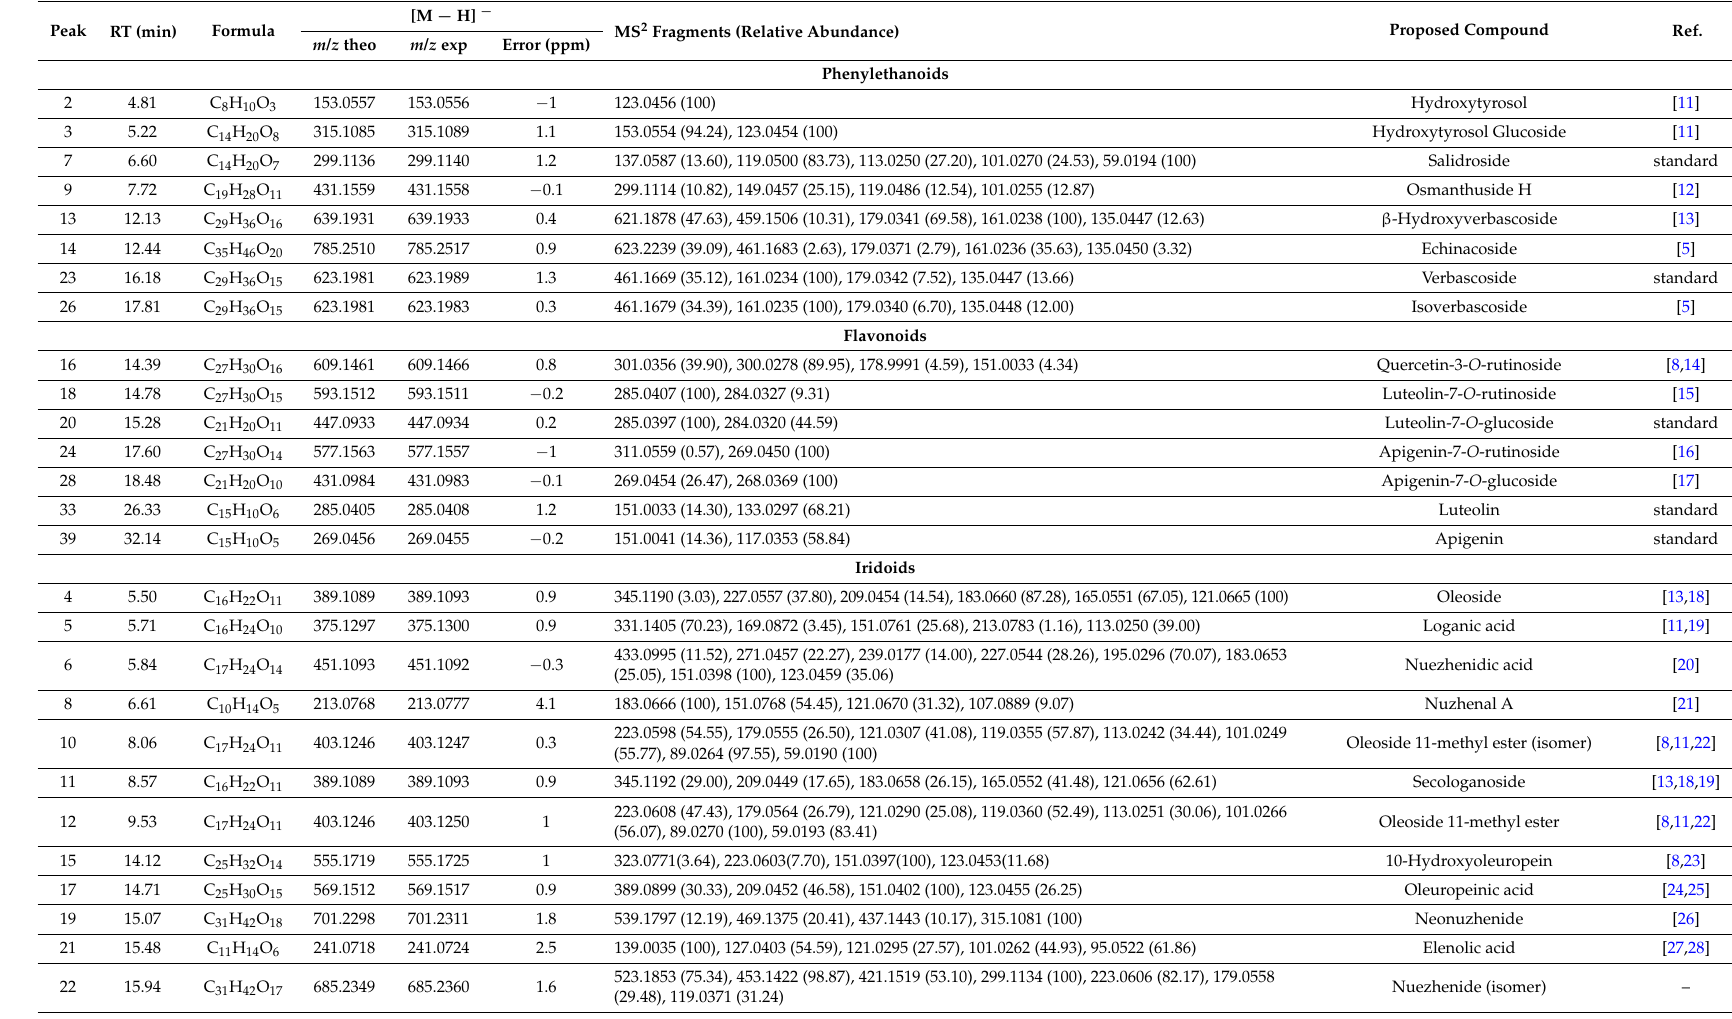
Table 1. Identification of 51 constituents of processed-LLF by UHPLC-ESI-Q-TOF-MS/MS in negative